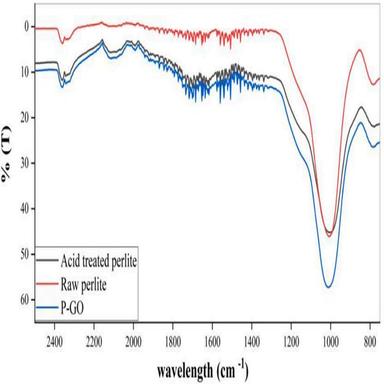
FT-IR spectrum of samples.